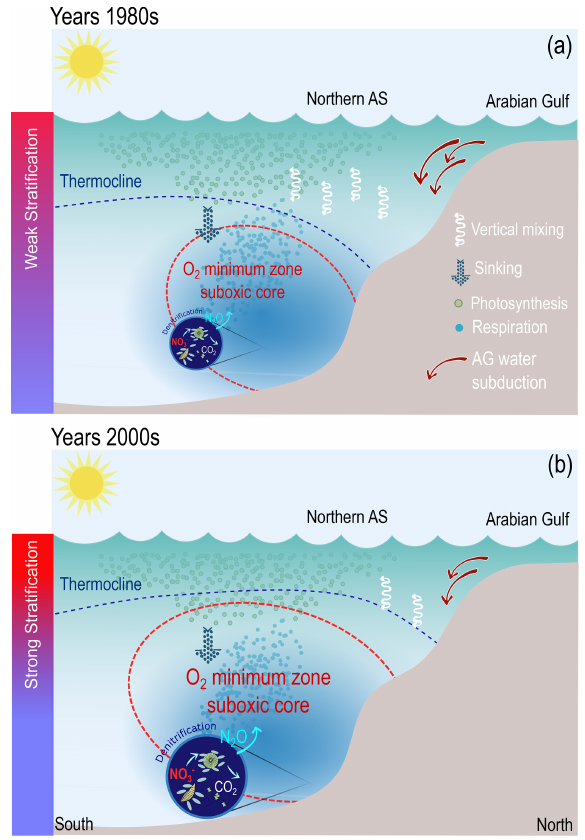
Figure 11. A schematic summarizing the main processes respon- sible for the O 2 changes in the northern AS. (a) Conditions in the early 1980s: cool conditions favor weak stratification, enhanced ver- tical mixing and subduction of high-density Gulf water in the north- ern Arabian Sea, resulting in a deeper and smaller OMZ suboxic core. (b) Conditions in the early 2000s: warm conditions enhance vertical stratification and cause a weaker vertical mixing and a re- duced subduction of the Gulf water in the northern Arabian Sea, resulting in an expansion of the suboxic core of the OMZ and an increase in denitrification. Stronger upwelling-favorable winds also contribute to raise the thermocline depth and hence bring O 2 - depleted waters upwards further near the